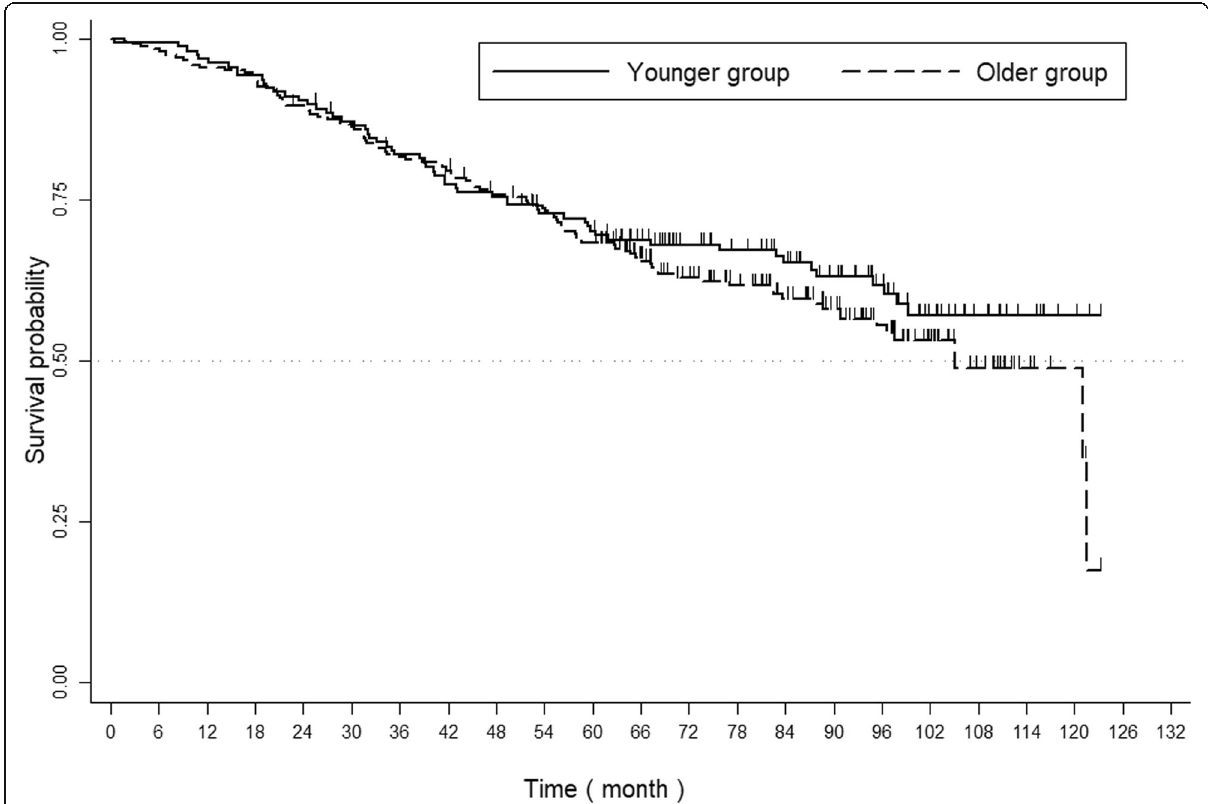
Fig. 2 Kaplan – Meier survival curve of age